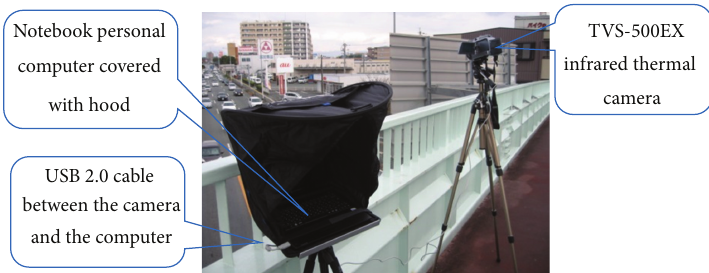
Figure 1: The infrared thermal camera and the notebook personal computer covered with the hood on a pedestrian bridge.